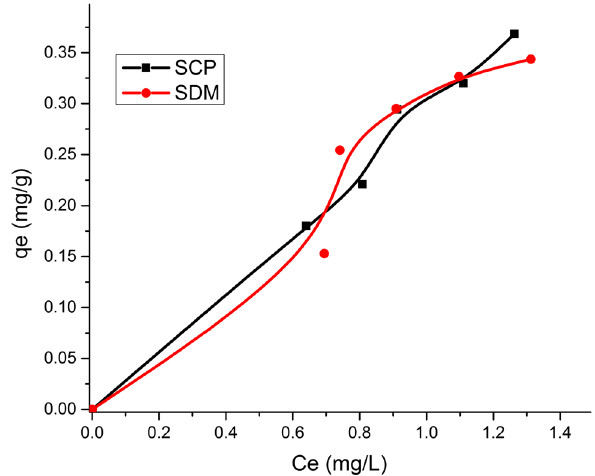
Fig. 7 Experimental adsorption isotherms SCP and SDM removal onto Fe-MC ( m = 0.1 g/50 mL, pH = 6.4, 303 K, C o = 1-2